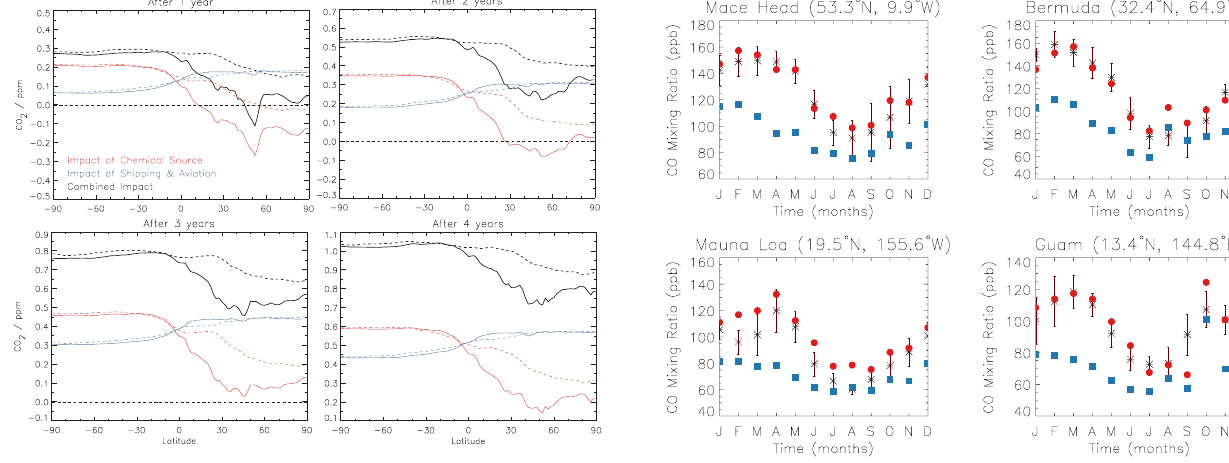
Fig. 10. Monthly-averaged model CO (blue squares) and the model with assimilated TES CO (red circles) compared with CO surface measurements (black asterisks) in 2006. Error bars on the measurements denote the one standard deviation variability in CO at that station for the given month during the period of